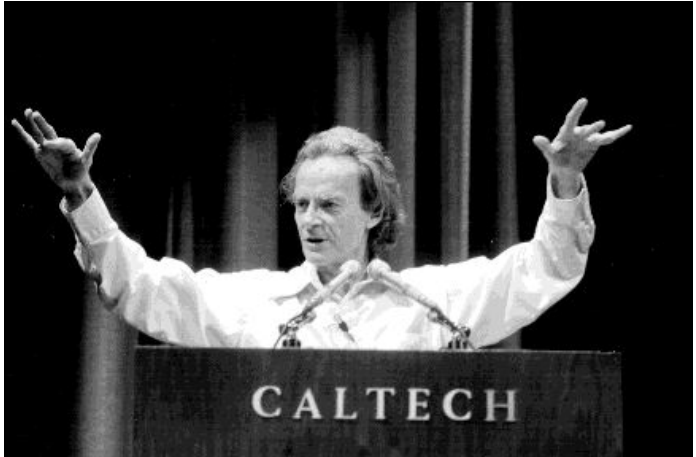
Figure 6. Richard Feynman lecturing at Caltech Seminar Day, 1978. Taken from